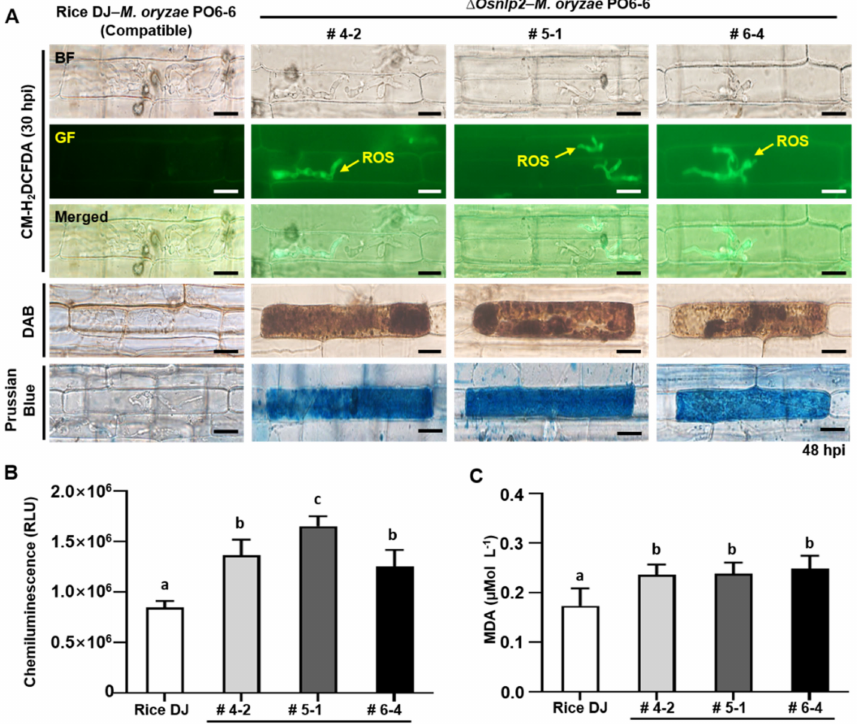
Figure 3. ROS and ferric ion accumulation and lipid peroxidation in leaf sheath cells of rice DJ and ∆ Osnlp2 mutants during virulent Magnaporthe oryzae PO6-6 infection. ∆ Osnlp2 KO mutant lines # 4-2, # 5-1, and # 6-4 were used in these experiments. ( A ) Images of ROS and ferric ion accumulation in rice leaf sheath cells. ROS accumulation was detected by CM-H 2 DCFDA and DAB staining, and ferric ion (Fe 3+ ) accumulation was visualized by Prussian blue staining. All images were taken using a fluorescence microscope (Zeiss equipped with Axioplan 2) with bright field or GF filters (Ex/Em: 488 nm/505–550 nm wavelengths). BF, bright field; GF, green fluorescence; hpi, hours post inoculation. bars = 10 µ m. ( B ) ROS quantification in rice leaf sheaths at 48 hpi. ROS quantities in rice cells were detected by a chemiluminescence assay using a GloMax 96 Microplate Luminometer (Promega, Madison, WI). Values are means ± SD of total relative luminescence units (RLU) ( n = 10) from different rice sheath discs. ( C ) Determination of lipid peroxidation levels in rice leaf sheaths at 48 hpi. Lipid peroxidation was determined by quantifying malondialdehyde (MDA). Values are means ± SD ( n = 4) of MDA concentrations in leaf sheath from different plants. Different letters above the bars indicate significantly different means, as determined by the least significant difference (LSD) test ( p <